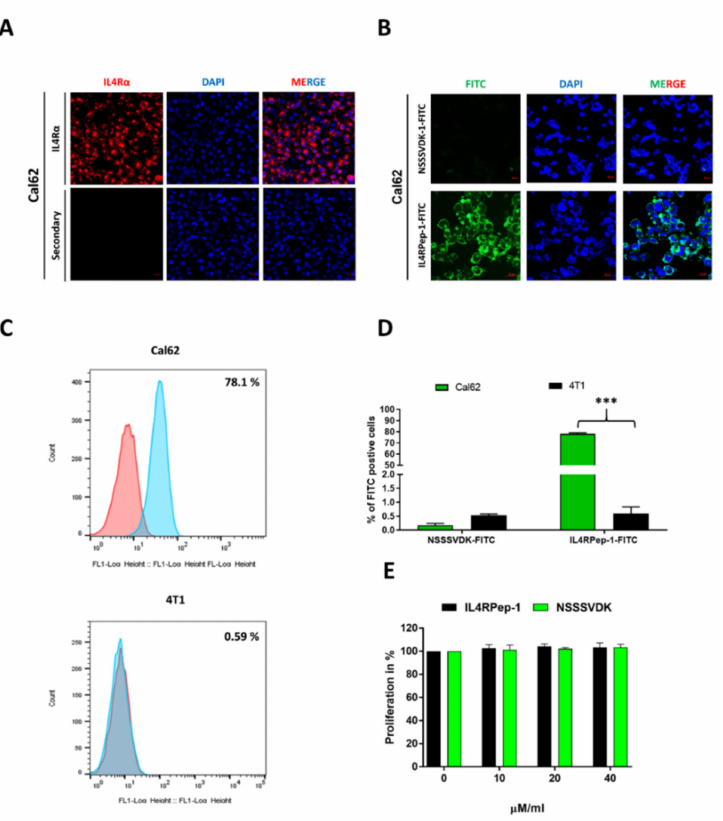
Figure 4. Expression of interleukin-4 receptor (IL4R) in thyroid cancer cells and preferential binding of IL4RPep-1 to IL4R α -expressing cancer cells in vitro. ( A ) Immunofluorescent imaging of Cal-62 using specific IL4R α antibody (scale bar: 20 µ m). ( B ) Immunofluorescent imaging of Cal-62 cells incubated with NSSSVDK-FITC and IL4RPep-1-FITC (scale bar: 20 µ m). ( C ) Flow cytometry analysis of Cal-62 and 4T1 cells incubated with NSSSVDK-FITC (red) and IL4RPep-1-FITC (blue). ( D ) Percentage of peptide-bound cells is represented on a bar graph. ( E ) Cell viability of Cal-62 cells incubated with 0, 10, 20, and 40 µ M/mL of NSSSVDK and IL4RPep-1 24 h post-incubation. Data are represented as means ± standard deviations (SD). Statistical differences between groups were analyzed using Student’s t -test. *** p <